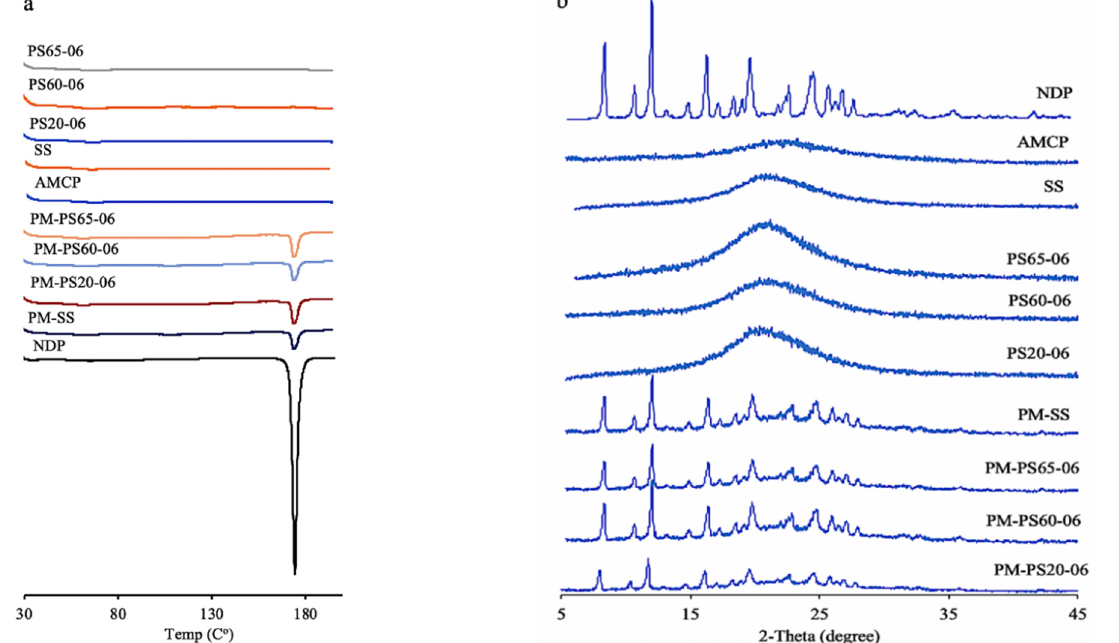
Figure 3. Thermograms ( a ) and X-ray diffraction patterns ( b ) of nifedipine, the solid solutions, and the physical mixtures.